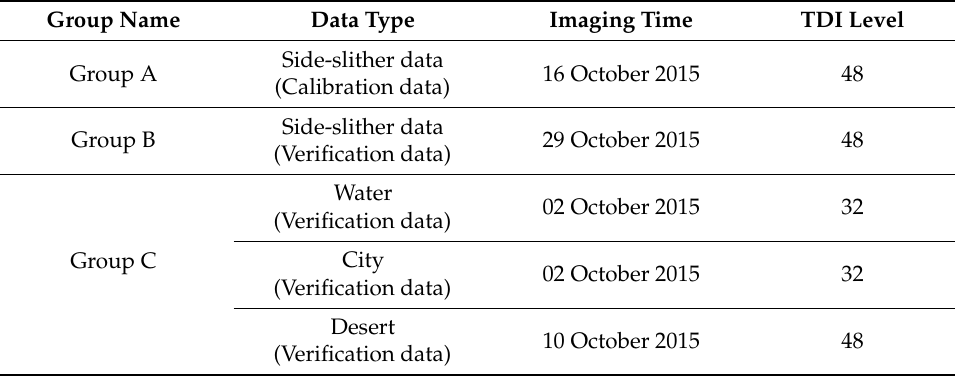
Table 1. Details of the experimental